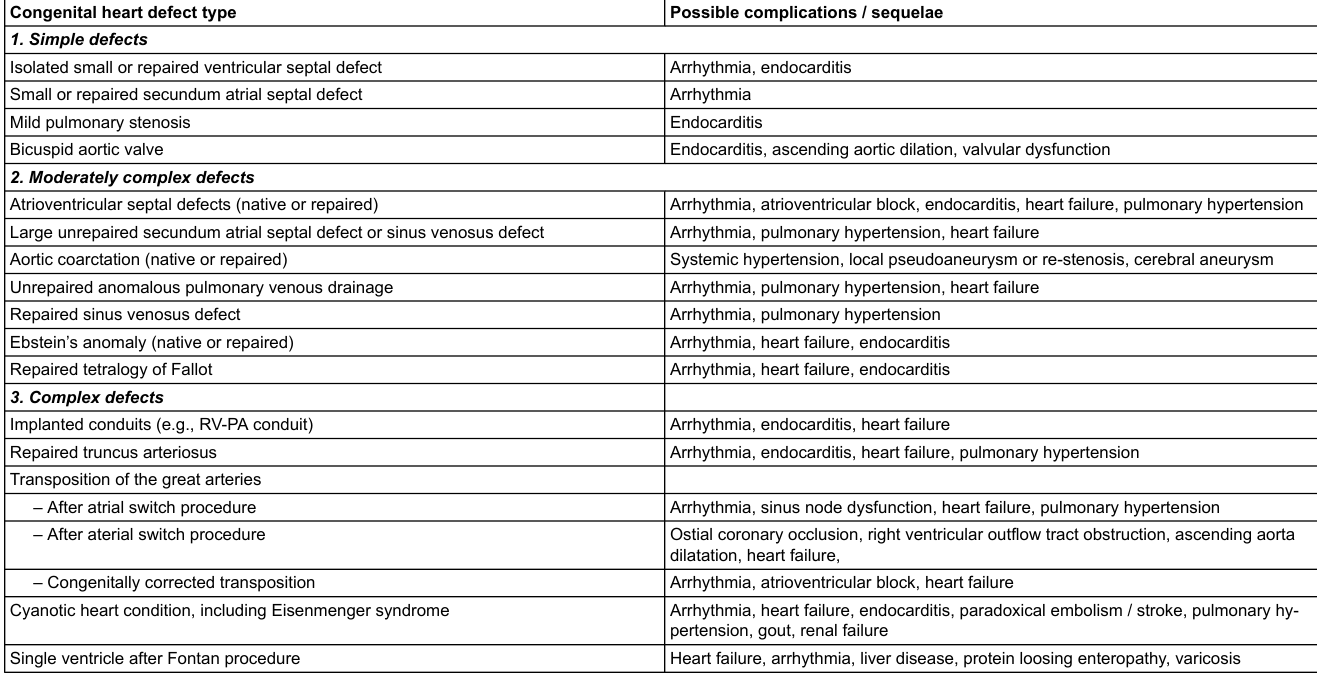
Table 1: Late complications in common congenital cardiac defects. Congenital heart defect